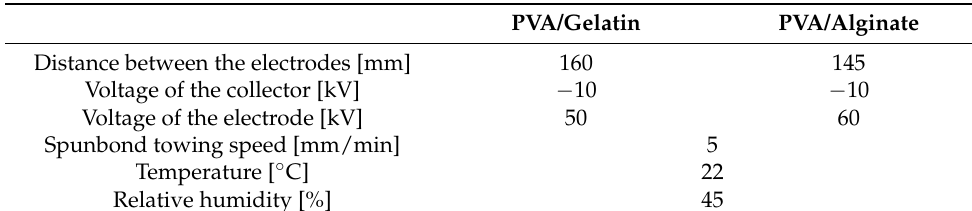
Table 1. Process parameters of the spinning of the selected solutions.